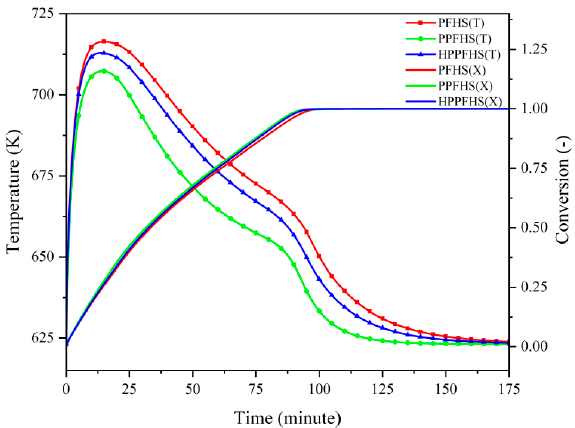
Figure 10. The average temperature (T) and conversion (X) of the material changed over time in the bed of three types of reactors (hydration, ε = 0.5, u = 25 m/s).